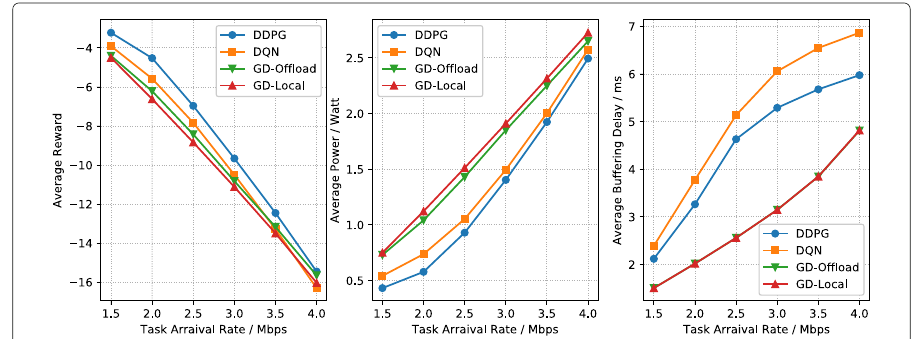
Fig. 6 Comparison of testing results for a single user agent with w 1 =